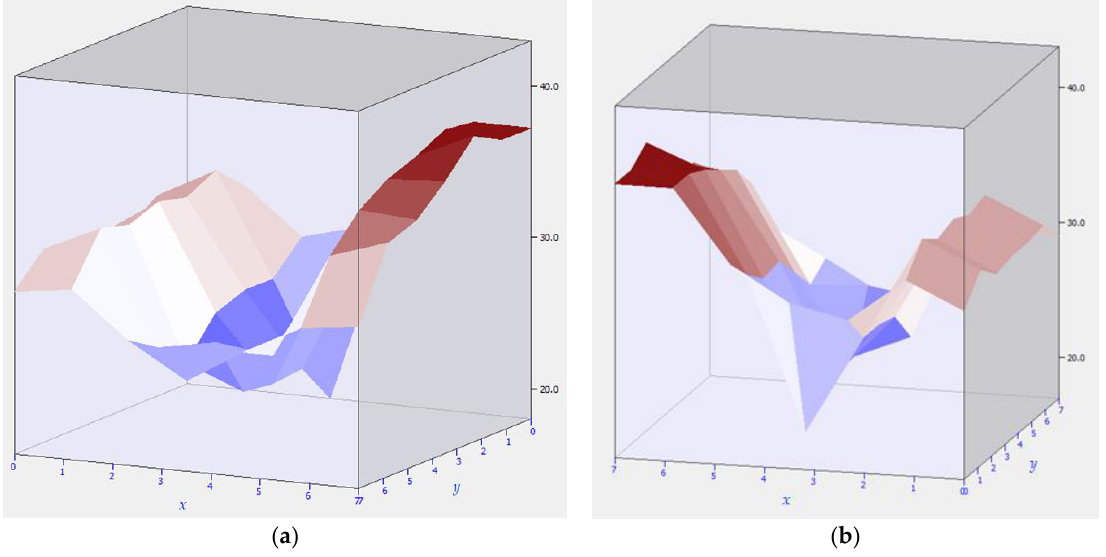
Figure 5. Overheating of cathode No. 5 and part of the electrolysis cell bottom: ( a ) overheating area 4 – 5; ( b ) overheating area 5 – 6.